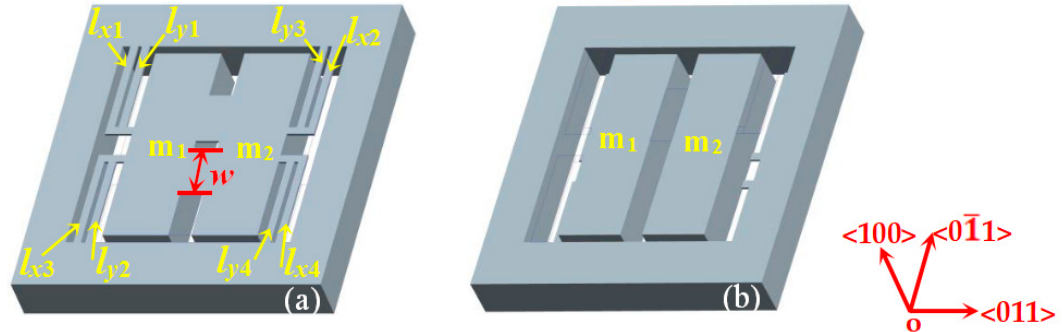
Figure 3. The structure model of the three-axis accelerometer: ( a ) top view; ( b ) bottom view.